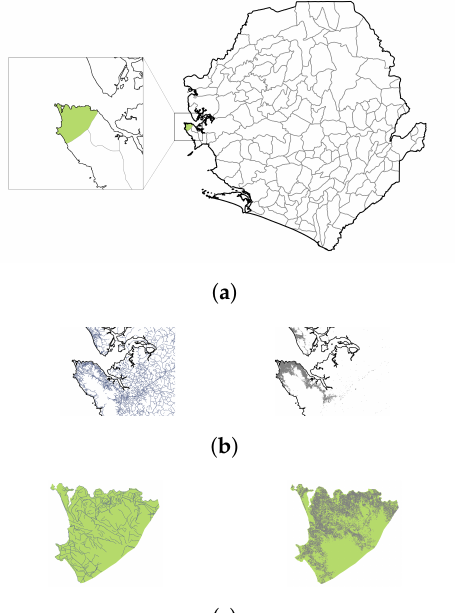
Figure 1. Parallelization scheme of geospatial data on streets and building footprints. ( a ) For each country, the most granular administrative boundaries are obtained from the Database of Global Administrative Areas (GADM); the country border of Sierra Leone is shown in black, while administrative boundaries are in grey. Highlighted in green and in inset is the administrative unit containing known informal settlements in the capital city of Freetown. ( b ) The national street networks layer (left, blue lines) and building footprints layer (right, gray polygons), in the region around Freetown, extracted from GeoFabrik data. Only the top 20% of roads by LineString length and top 20% of buildings by Polygon area are shown. ( c ) Each country-level layer is intersected with the boundaries of each administrative unit to obtain unit-level extracts of road networks (left) and building footprints (right). The block extraction and topological analysis, detailed below, is then run on the unit-level extracts in